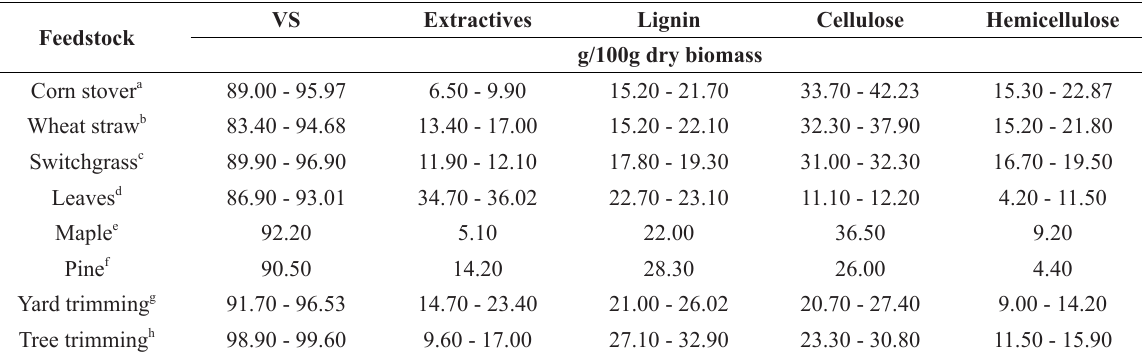
Ranges of feedstock